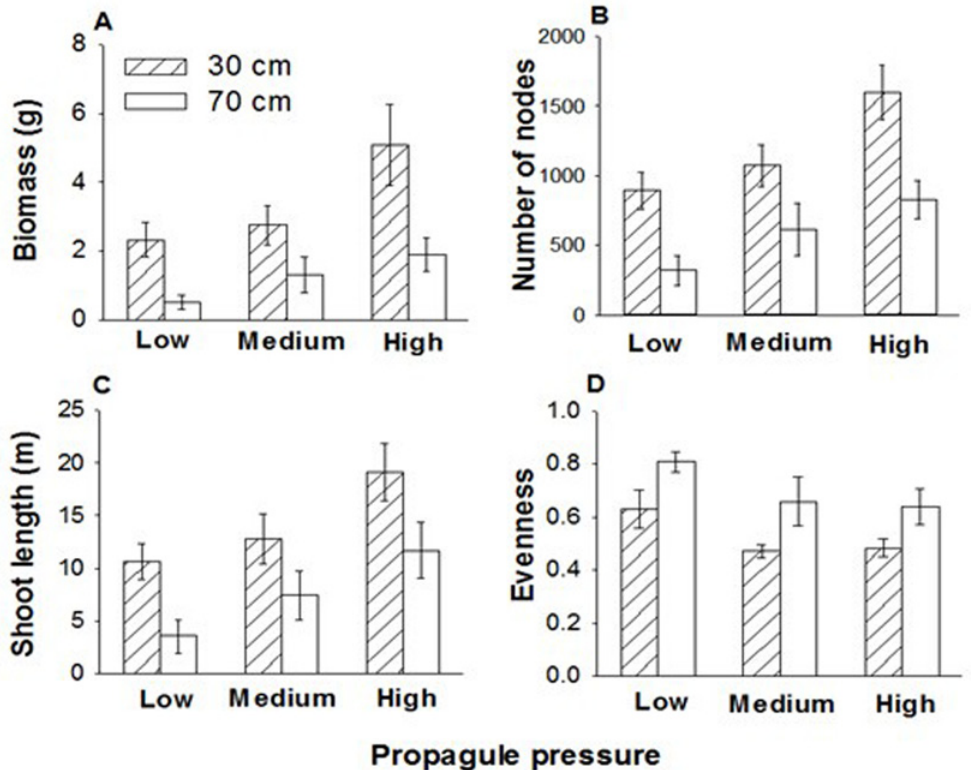
Fig 1. Effects of propagule pressure and water depth on the growth and evenness of the submerged macrophyte communities. Mean values ( ± SE) are